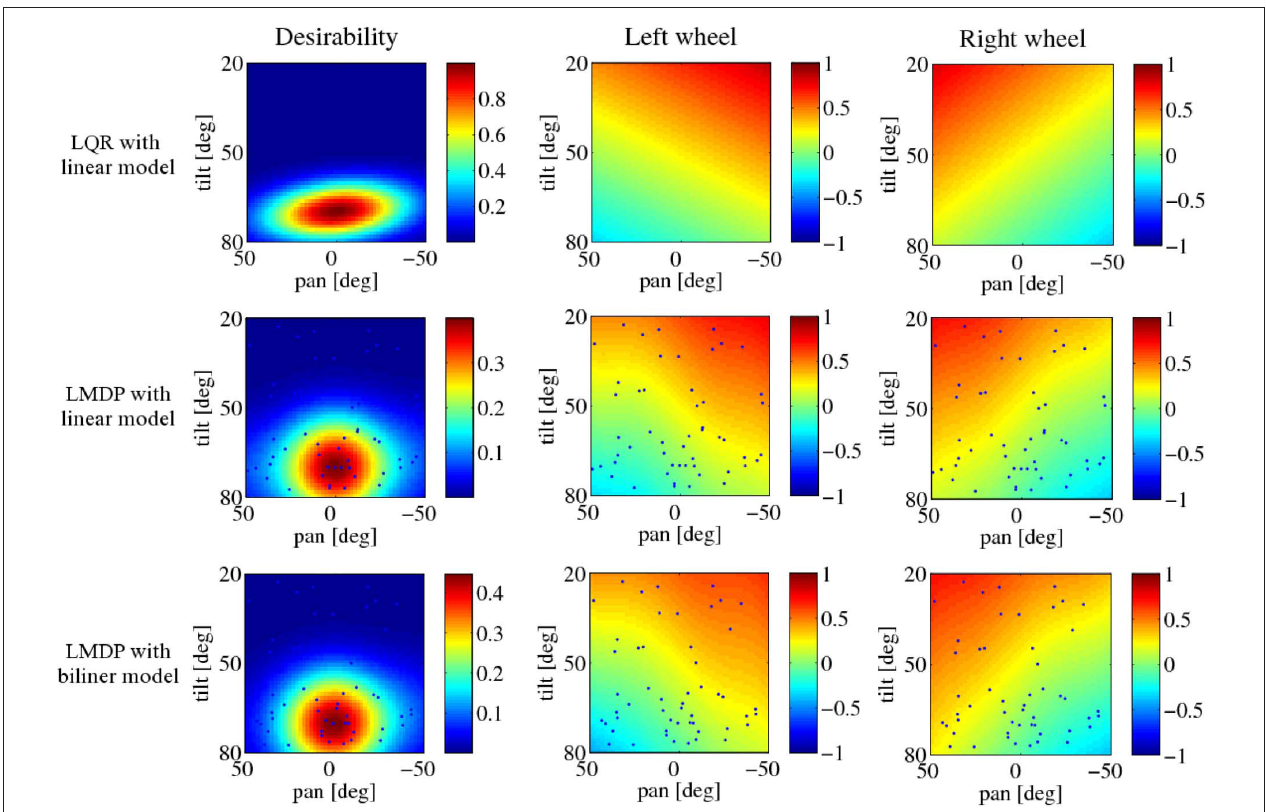
FIGURE 9 | Results of the robot navigation task. LQR with the linear model is at the top, LMDP with the linear model in the middle, LMDP with the bilinear model at the bottom, z ( x ) on the left, u ∗ left ( x ) on the center, u ∗ right ( x ) on the right. Black dots represent the centers of the basis functions ϕ ( x , u ) .